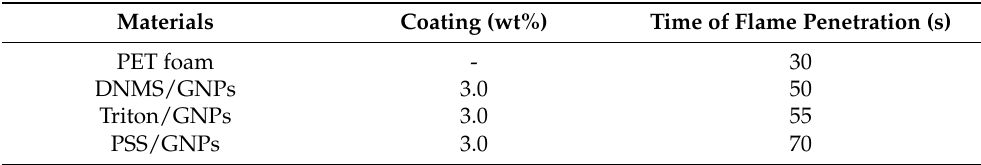
Figure 5. The flame penetration curves of samples with both sides covered by GNPs coating of solutions of DNMS, Triton, and PSS dispersants. Table 1. Flame penetration times for PET foam and coated samples with one face